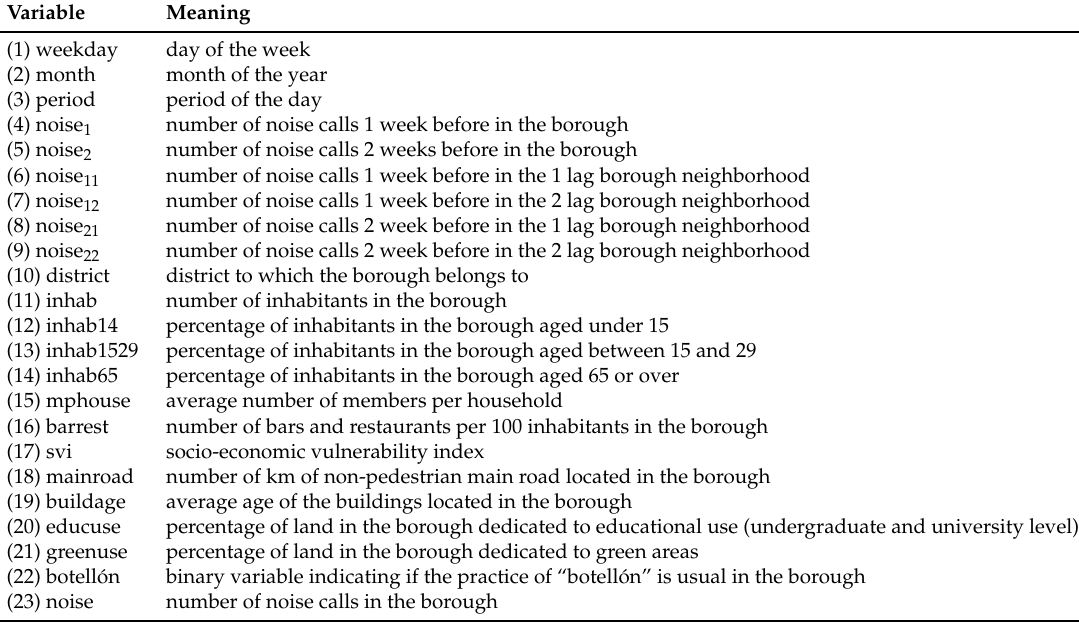
Table 1. Enumerated list of variables used in the analysis and their